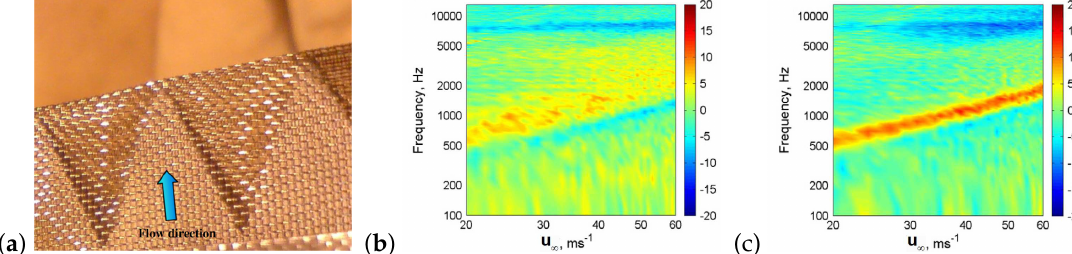
Figure 11. Contours of streamwise vorticity (redrawn from [134]) for: ( a ) the baseline trailing edge; and ( b ) the serrated trailing edge.